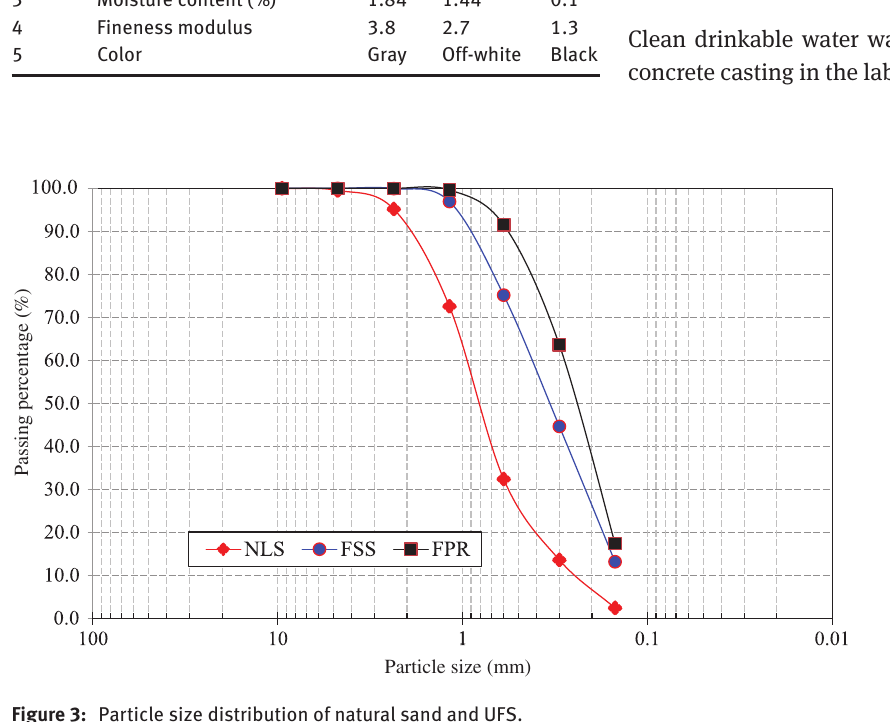
Figure 3: Particle size distribution of natural sand and UFS.